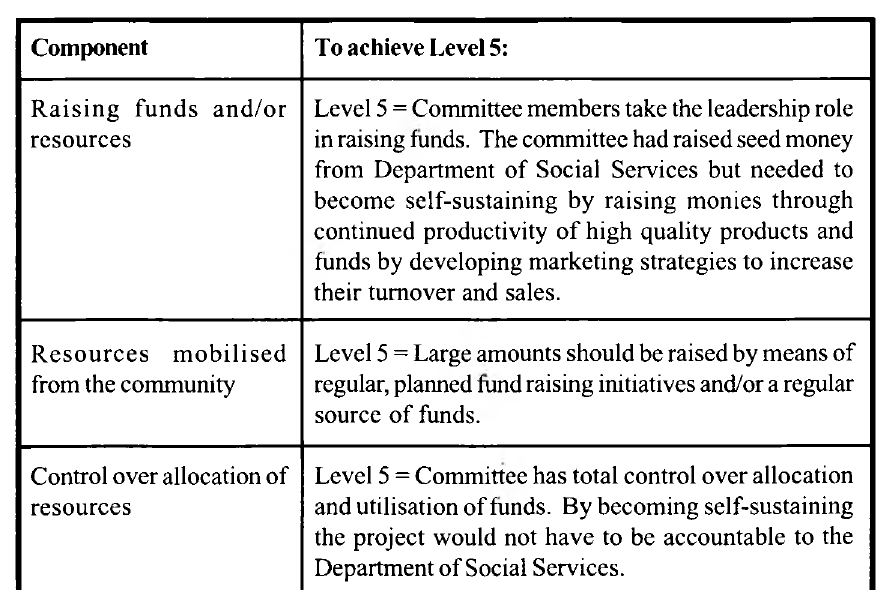
Table B Factor: Resource mobilisation by the Lesedi Youth Association’s